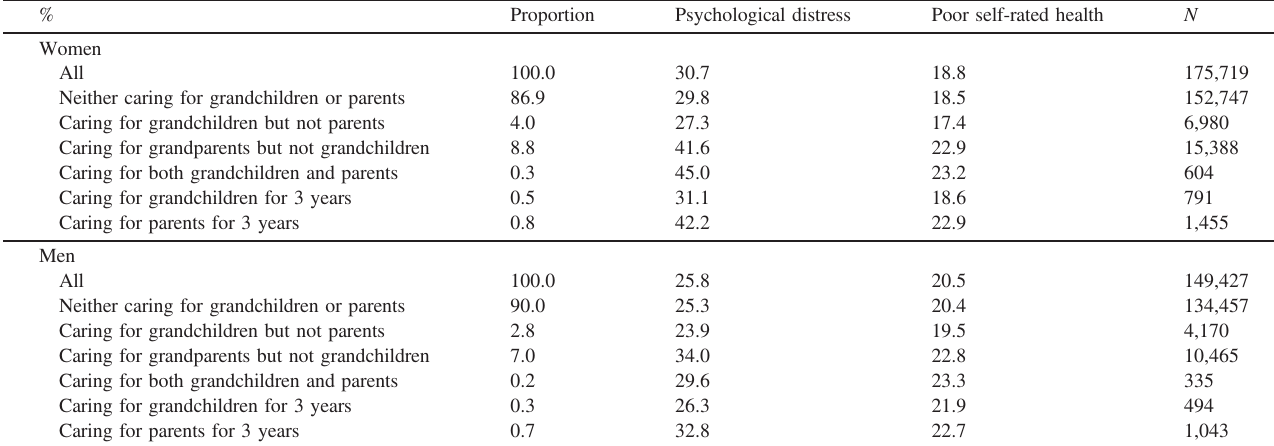
Table 2. Di ff erence in prevalence of psychological distress and poor self-rated health between caregivers and non-caregivers % Proportion Psychological distress Poor self-rated health N Women All 100.0